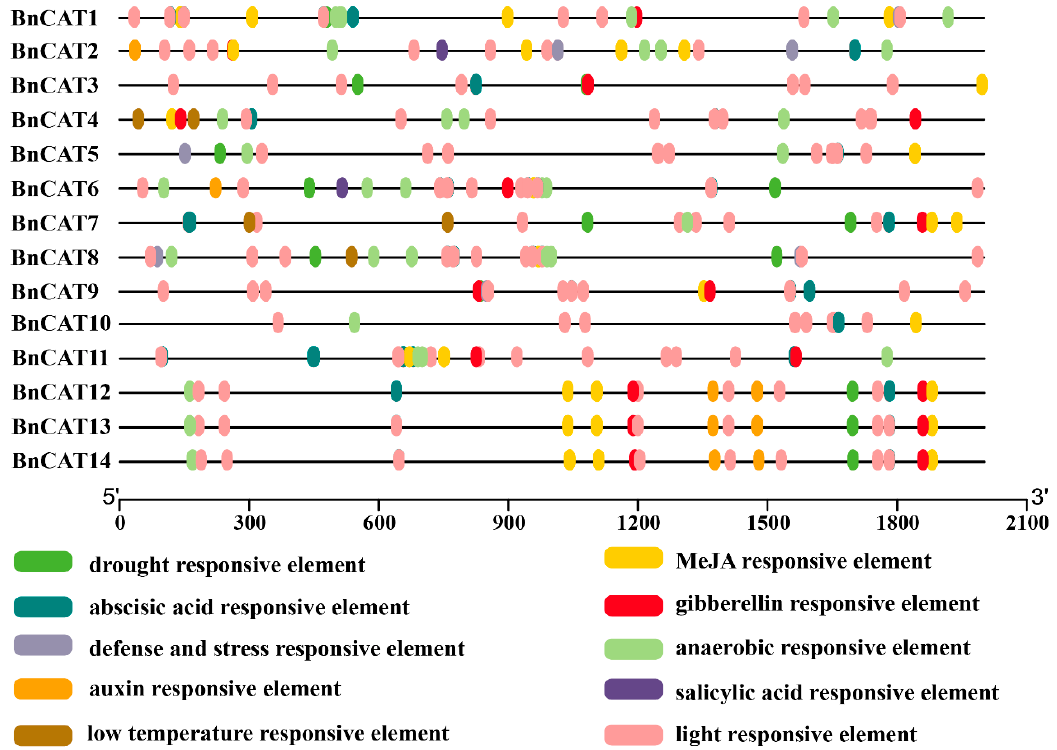
Figure 5. Cis -elements in the promoters of the BnCAT genes that are associated with different hormone- and stress-responsive elements. Different color boxes show different identified cis -elements.